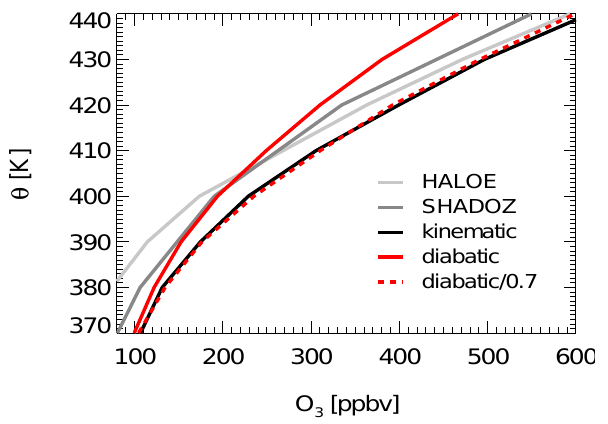
Fig. 8. Mean tropical ozone profiles, reconstructed from trajecto- ries (diabatic; diabatic with vertical velocity multiplied by a factor 0.7; kinematic), HALOE and SHADOZ observations.